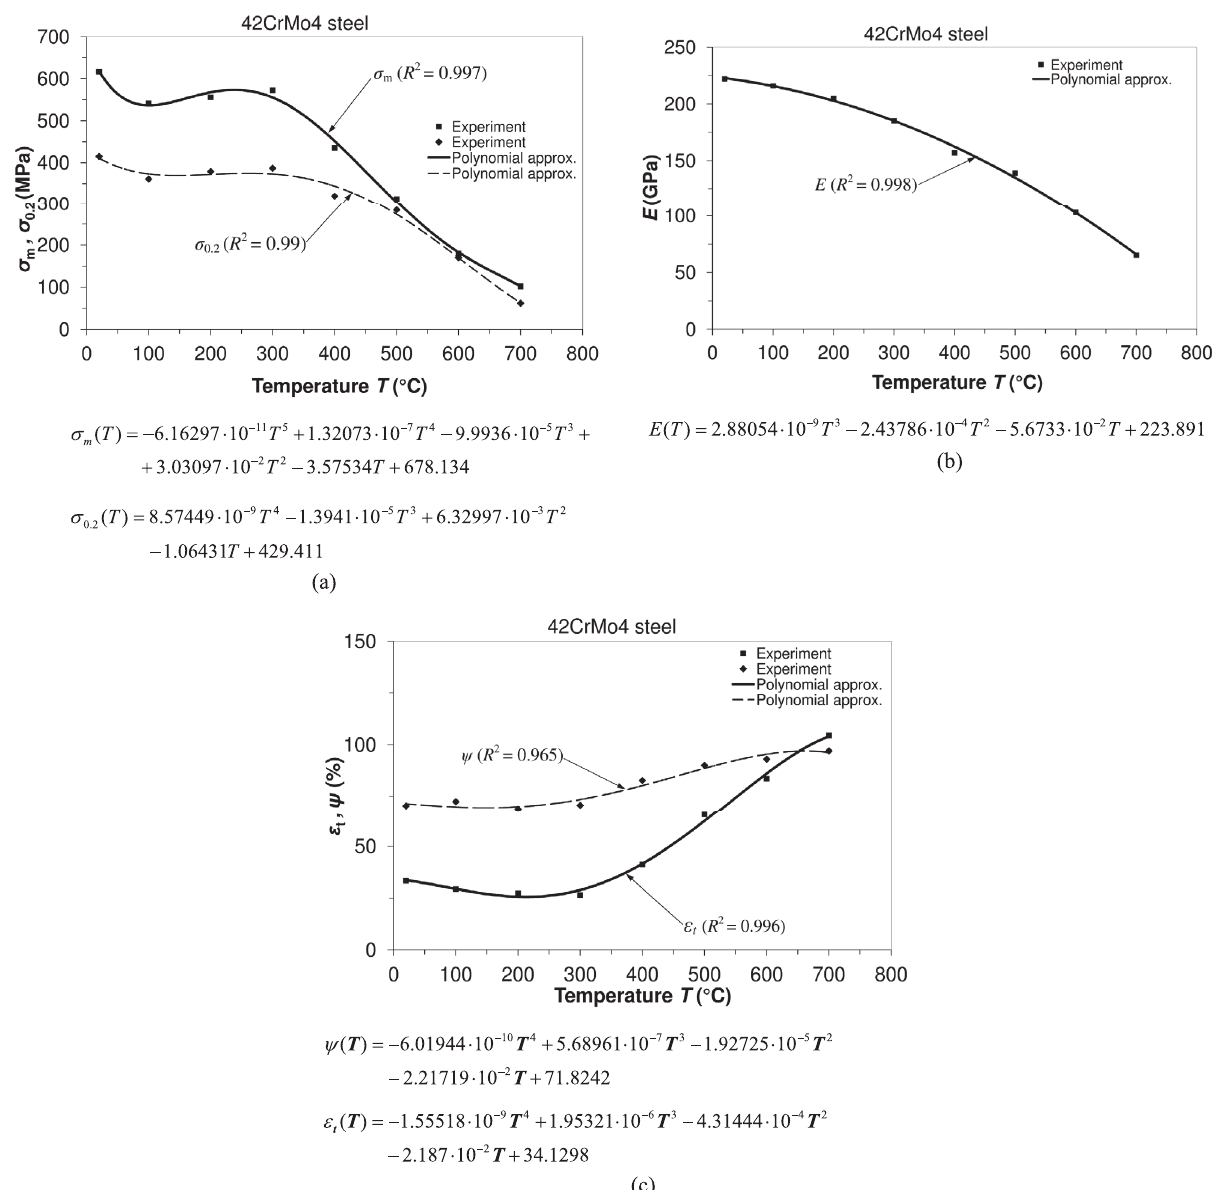
Fig. 2: Steel 42CrMo4: Experimental data of material properties versus temperature and appropriate polynomial approximations. (a) Mechanical properties ( s m , s 0.2 ) versus temperature. (b) Modulus of elasticity ( E ) versus temperature. (c) Elongation ( e t ), and reduction in area ( y ) versus